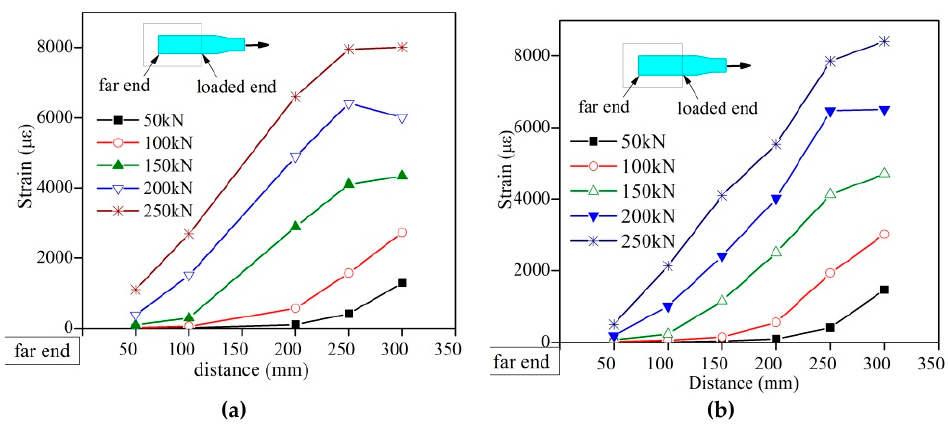
Figure 6. SC-P’s strain distribution. ( a ): SC-P_1; ( b ) SC-P_2.